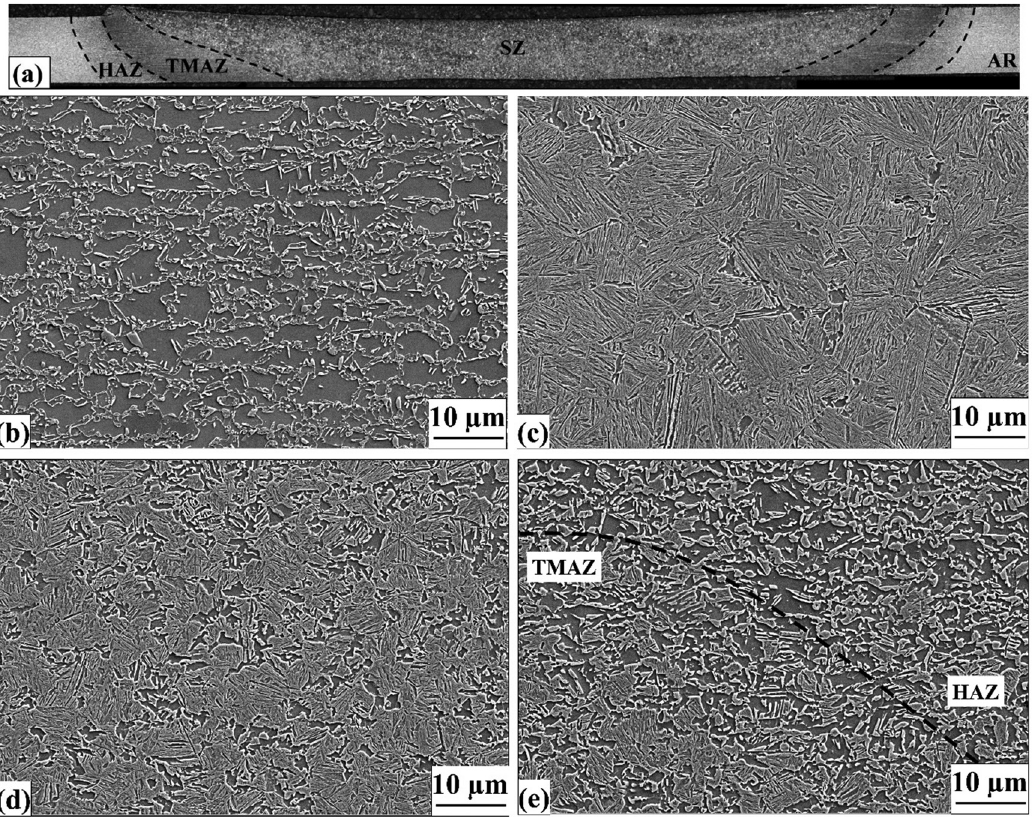
Figure 2: SEM microstructures of DP600 before and after FSP: ( a ) Low magni fi cation microstructure of processed region, ( b ) AR - steel, ( c ) SZ, ( d ) TMAZ and ( e ) transition from TMAZ to